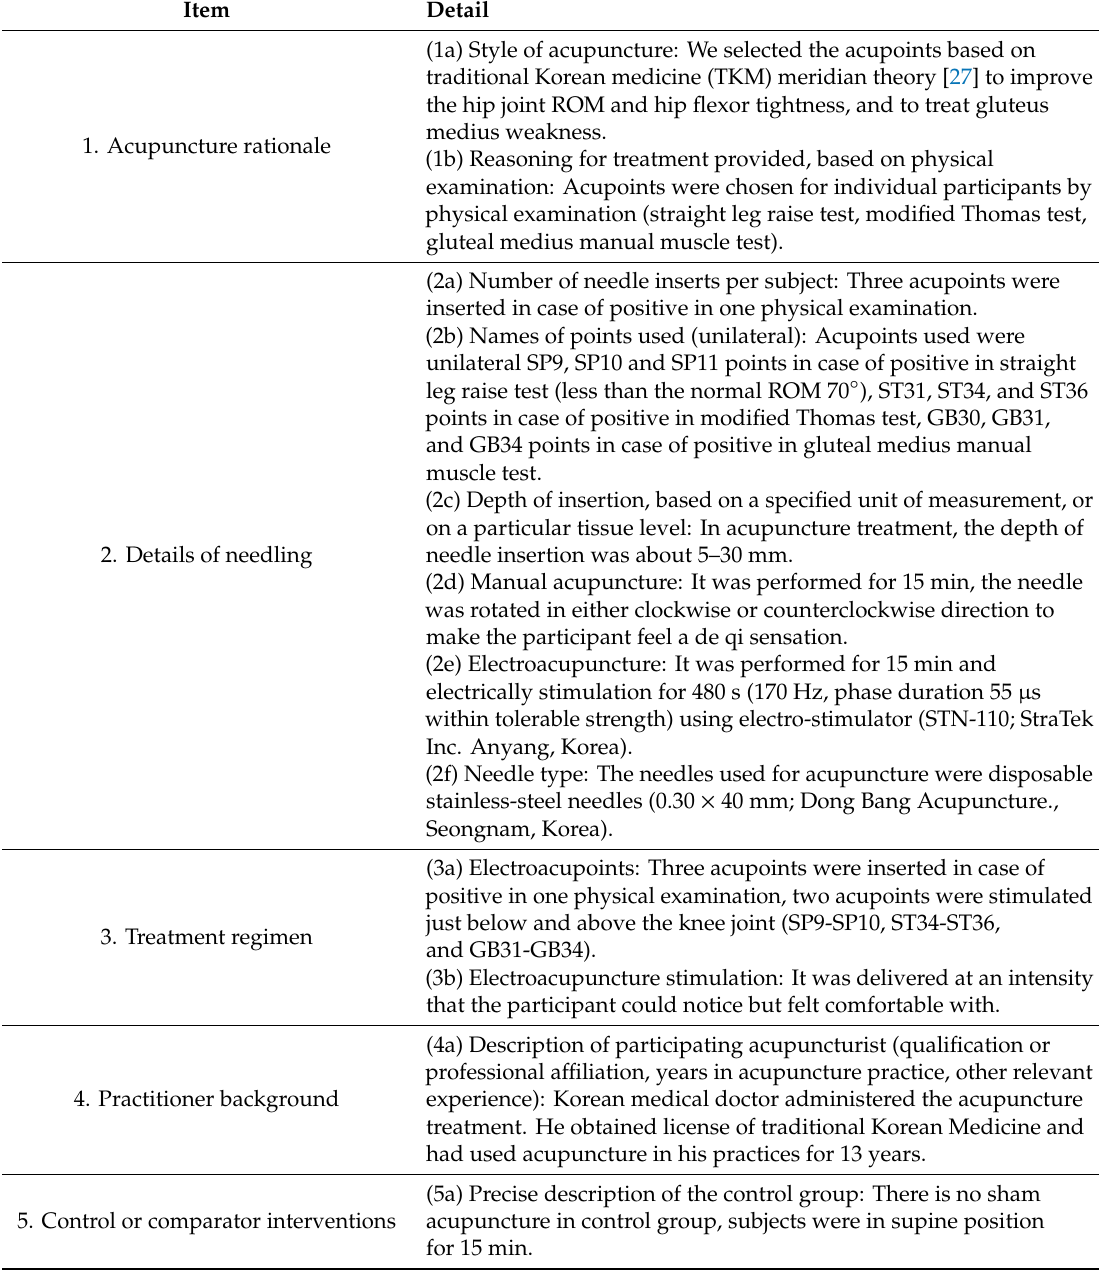
Table 2. Treatment by the STRICTA